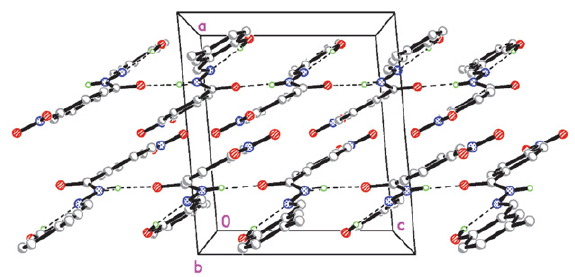
Figure 7. Molecular packing diagram of 3 , viewed along the b axis. Hydrogen bonds are shown as dashed lines.